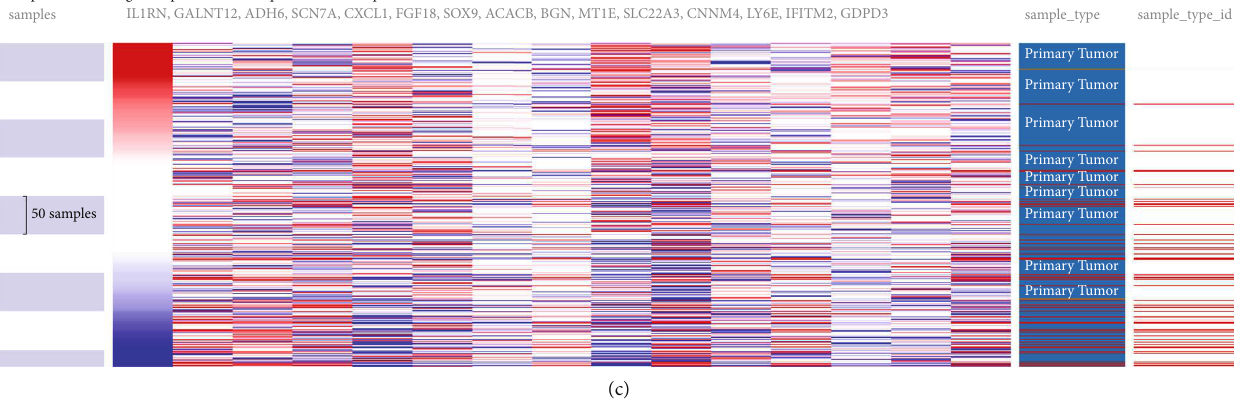
Figure 3: GO enrichment, interaction network, and biological process analyses of the seed genes. (a) BP, MF, and CC of seed genes. (b) The BP analysis of hub genes was constructed using BiNGO; P < 0 : 01 was considered statistically signi fi cant. (c) Hierarchical clustering of hub genes was constructed using UCSC. The samples under the pink bar are non-cancerous samples, and the samples under the blue bar are HCC samples. Upregulation of genes is marked in red; downregulation of genes is marked in